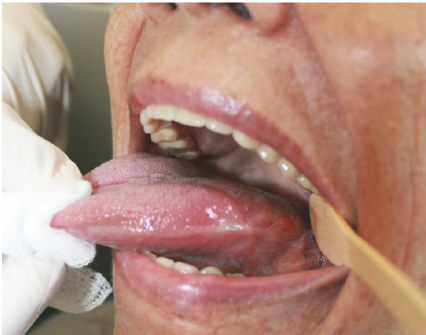
Figure 11: Postoperative month